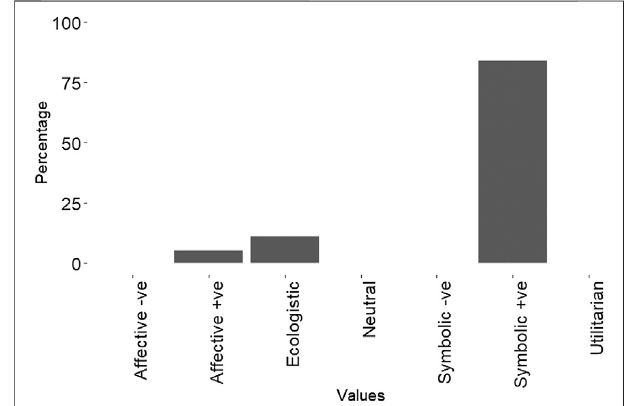
FIGURE 6 | The mythical snow lion was predominantly linked to positive symbolism (84.2%), which associated the animal with positive cultural beliefs and values, followed by ecologistic (10.5%) and positive affective values (5.2%). The total number of narratives was